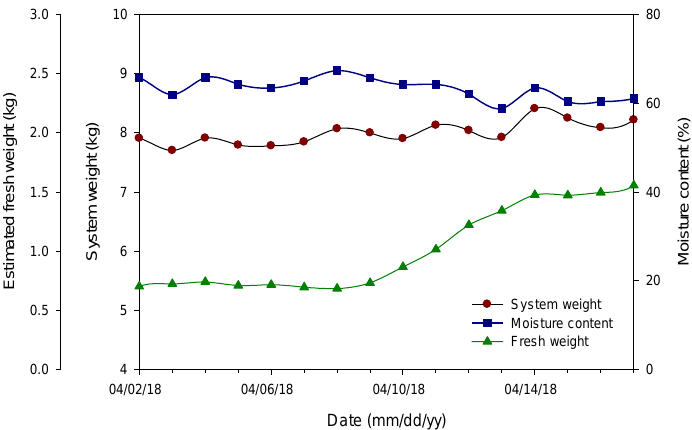
Figure 5. Changes in total system weight, moisture content, and fresh weight from 02 Apr. to 17 Apr., 2018.